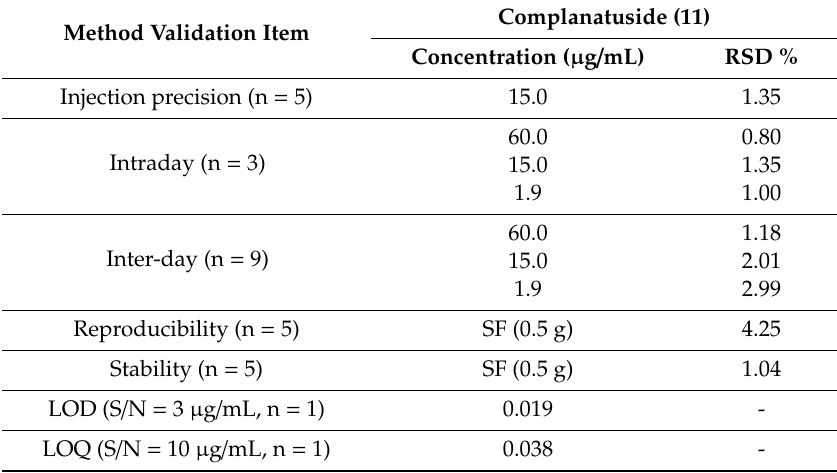
Figure 2. The key HMBC and 1 H- 1 H COSY correlations of compounds 2 , 4 , 5 , 8 , and 9 . Table 2. Method validation of complanatuside quantification by